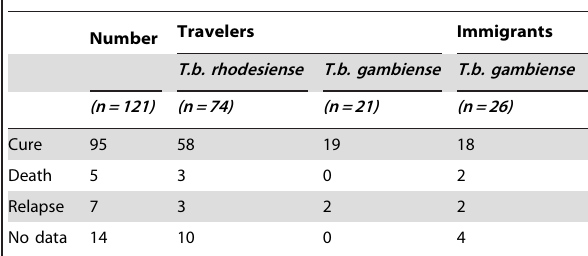
Table 6. Response to treatment.